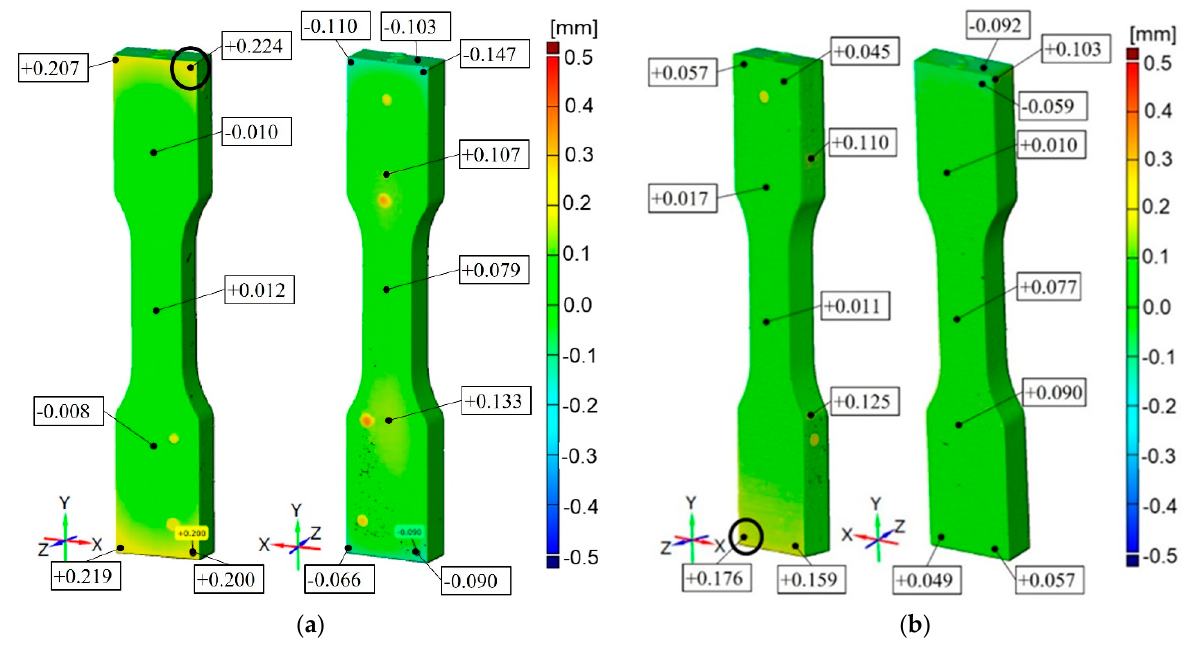
Figure 14. Geometric accuracy [mm] for the specimens made of VisiJet M2R-WT material: ( a ) Raster orientation: horizontal (X-axis), specimen ID: 2; ( b ): Raster orientation: vertical (Z-axis), specimen ID: 5.